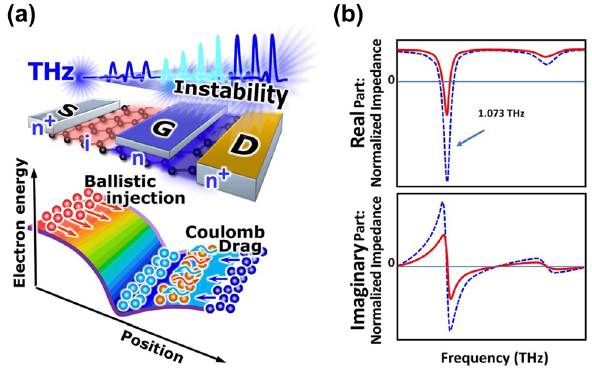
Figure 14: The Coulomb drag effect in a lateral n + – i – n – n + GFET structure with ballistic injection of graphene Dirac fermions makes it possible to strongly modify the current-voltage characteristics to produce ‘ gain ’ in the terahertz frequency range, leading to current- driven GDP instability and self-oscillatory generation of THz coherent radiation. (a) The band diagram illustrating the case when the gate is positively biased to make an n-type doping in the gated channel region and the drain is modestly biased so as to obtain an inverted potential slope between the gated channel and the drain side. The Coulomb drag effect promotes the reverse injection of quasi-equilibrated electrons fromthedrainside.Adaptedwithpermissionfromref.[72].Copyright 2022, Wiley-VCH GmbH. (b) Numerically simulated dynamic conduc- tivities demonstrating the resonant negative dynamic conductivity. The solid and dashed lines are for moderate and strong drag effect cases,respectively.Adaptedwithpermissionfromref.[72].Copyright 2022, Wiley-VCH